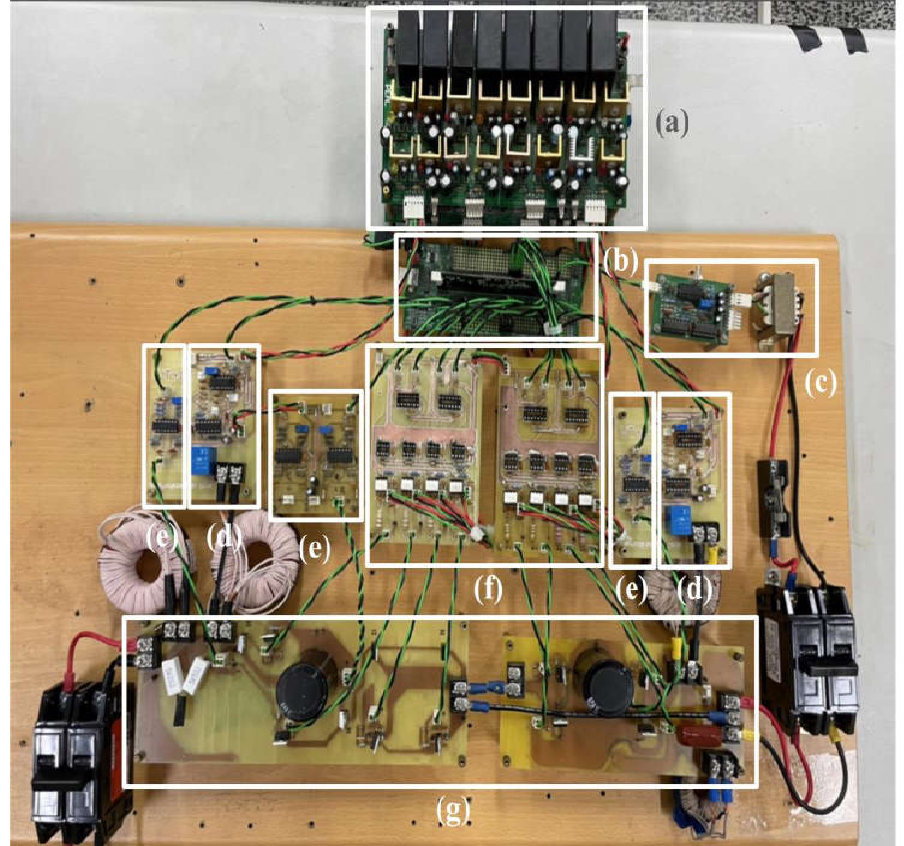
Figure 10. Photo of the prototype: ( a ) power supply; ( b ) digital signal processor board; ( c ) phase-lock loop board; ( d ) current-detection board; ( e ) voltage-detection board; ( f ) driver board; ( g ) power circuit board.